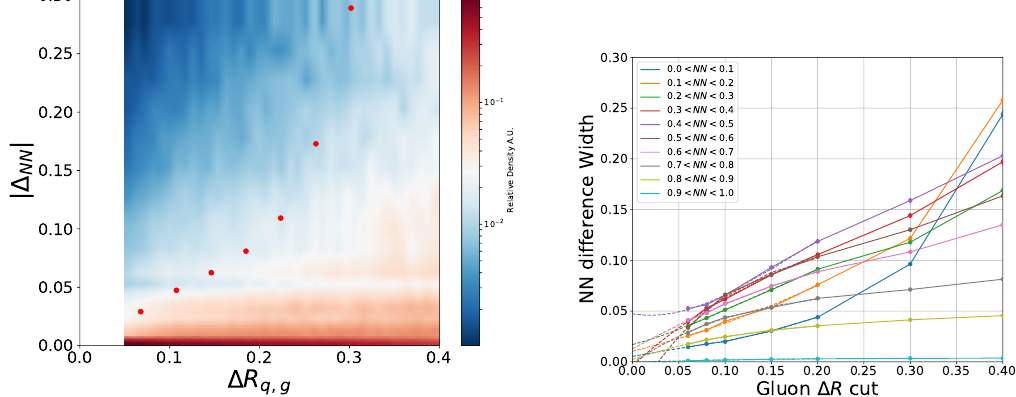
Figure 6 . Left panel: di(cid:11)erence in CNN output between merged and unmerged events, j (cid:1) NN j , as a function of the gluon’s angular separation from its nearest quark, (cid:1) R qg . Red dots show the width of the j (cid:1) NN j distribution. Background colors indicate the relative density of events for given (cid:1) R qg . Right panel: j (cid:1) NN j width as a function of (cid:1) R qg , binned in 10 NN output intervals. The lines indicate an interpolating curve (third-order polynomial) (cid:12)t to the data in each NN output bin.